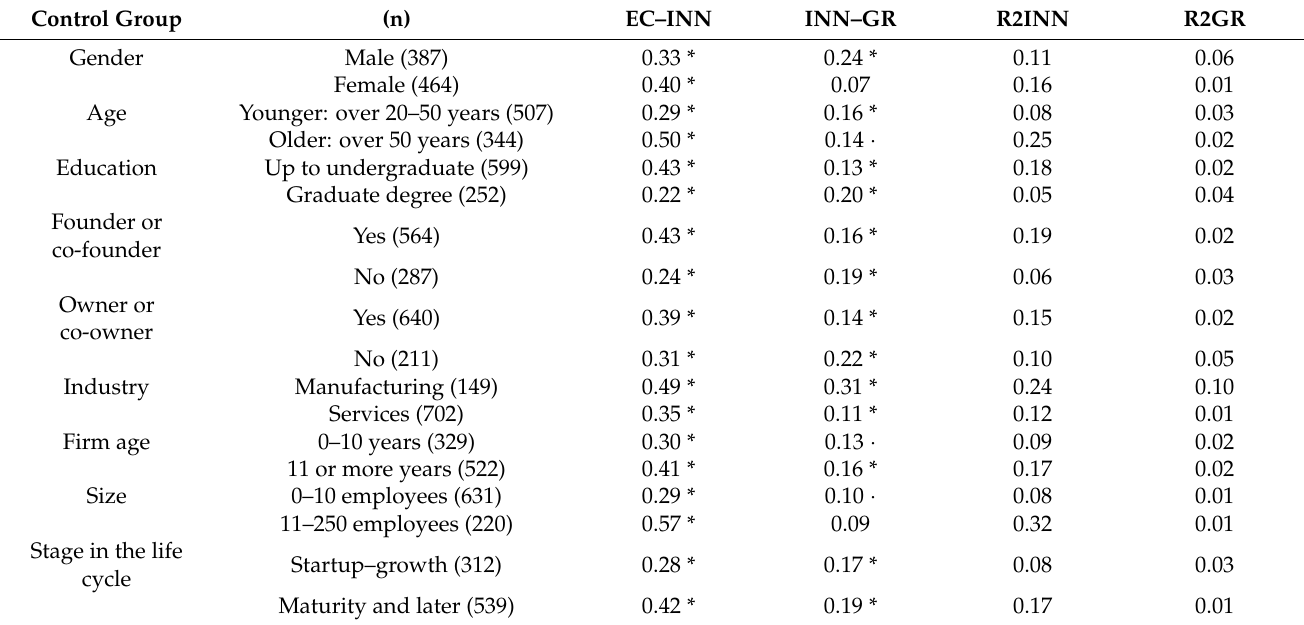
Table 5. Structural equation modeling results—controls (coefficients and variance